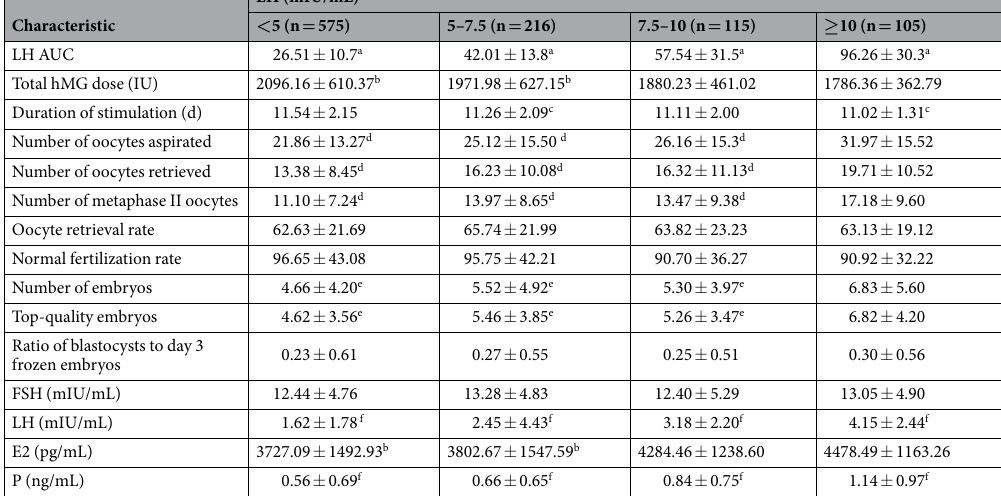
Table 2. Ovarian stimulation characteristics. Data are presented as the mean ± SD. a P < 0.001; b P < 0.001 vs. the group with LH ≥ 10 mIU/mL; c P < 0.05 vs. the group with LH < 5 mIU/mL; d P < 0.01 vs. the group with LH ≥ 10 mIU/mL; e P < 0.05 vs. the group with LH ≥ 10 mIU/mL; f P < 0.05. AUC: area under the